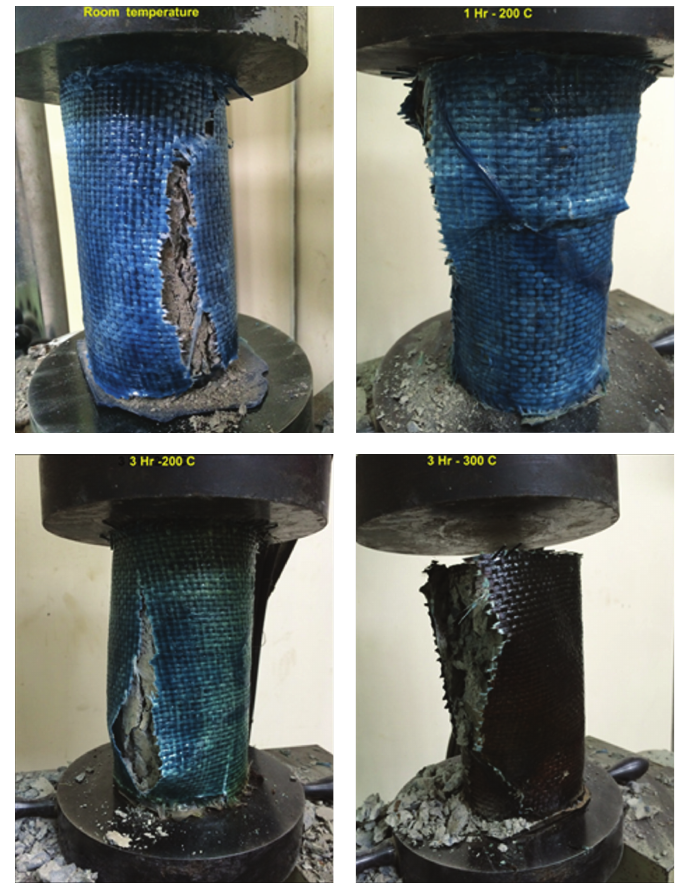
Figure 9: Failure of GFRP wrapped